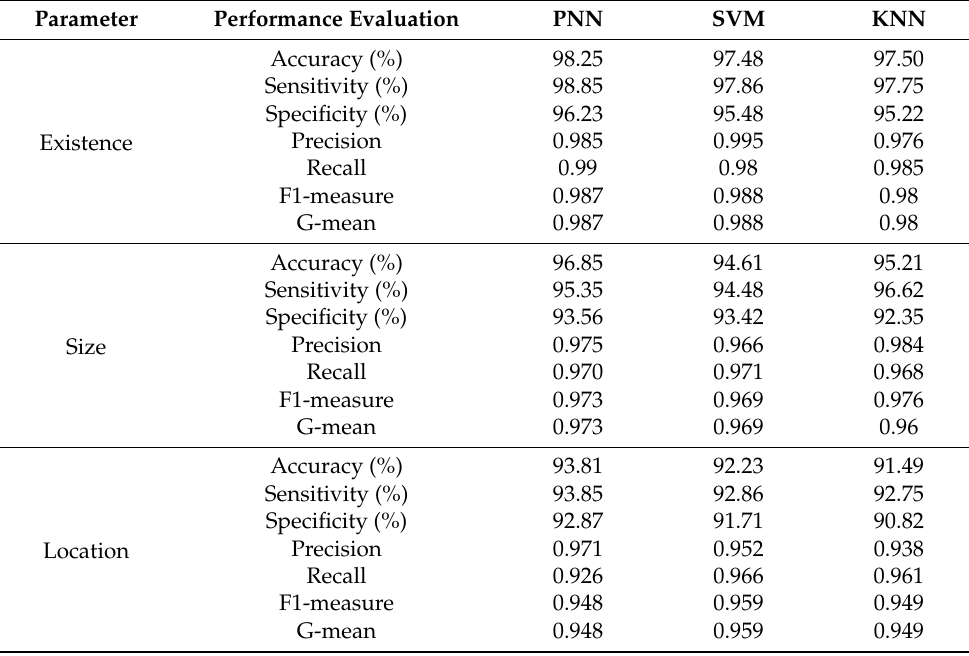
Table 6. Average classification results in comparison between different classifiers for proposed hybrid